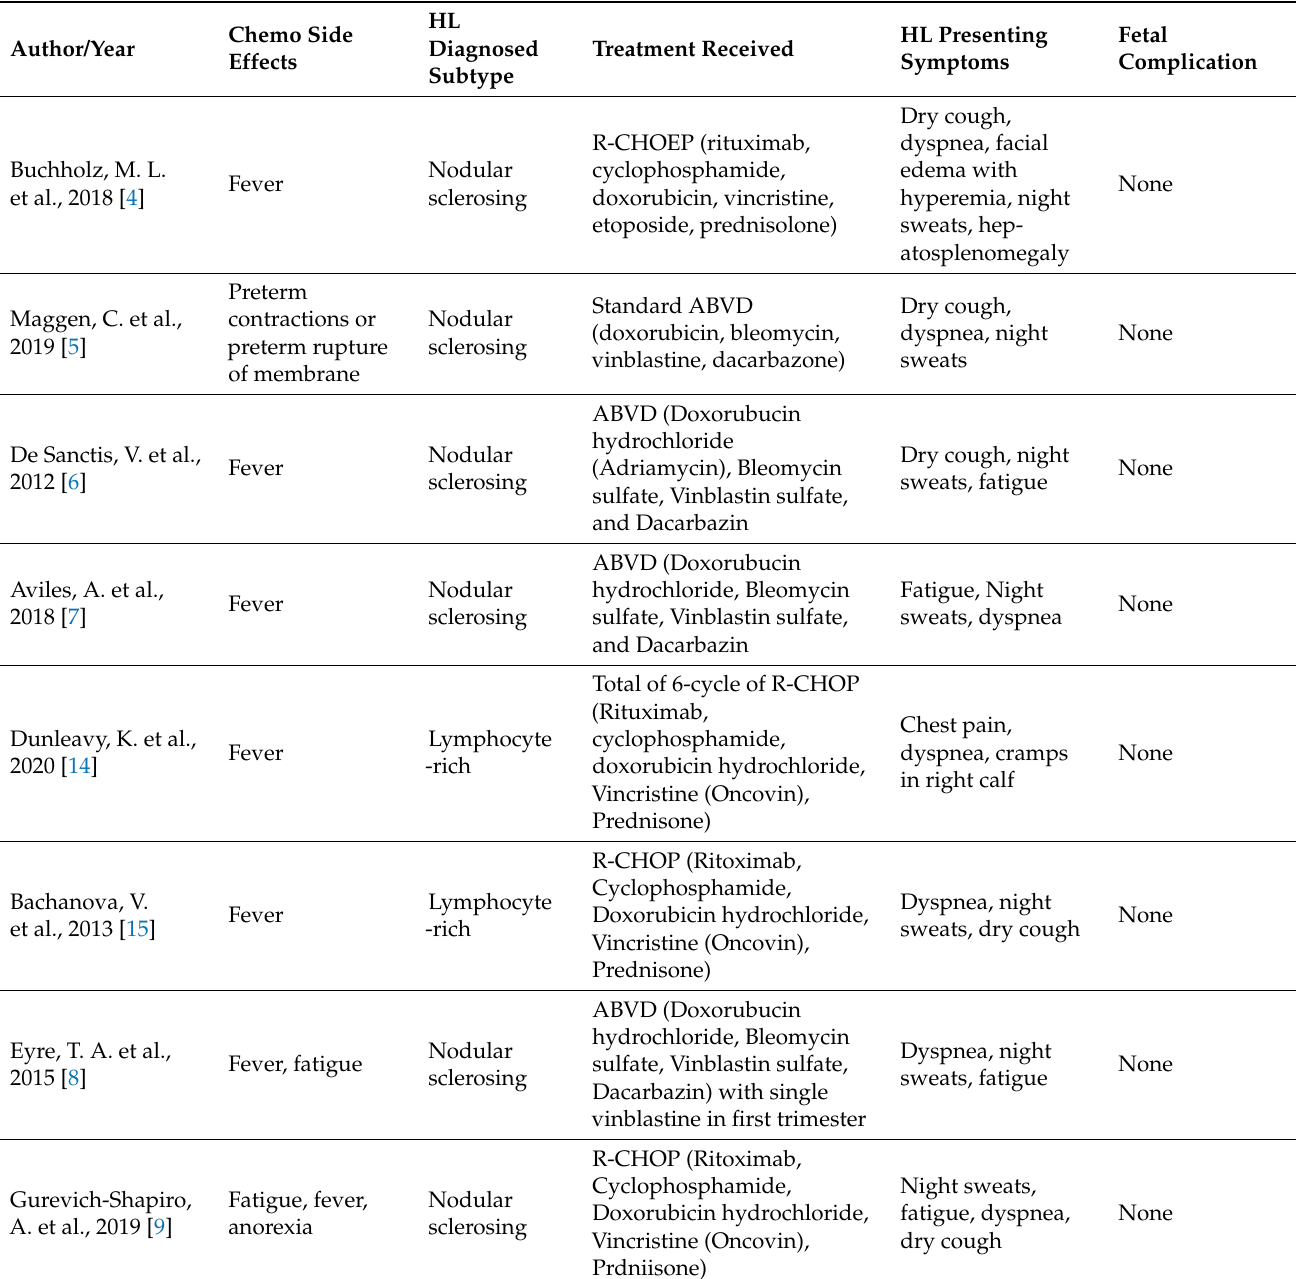
Table 1. Studies showing clinical symptoms, chemotherapeutic regimen, chemo adverse effects, and fetal complications in pregnant patients diagnosed with Hodgkin